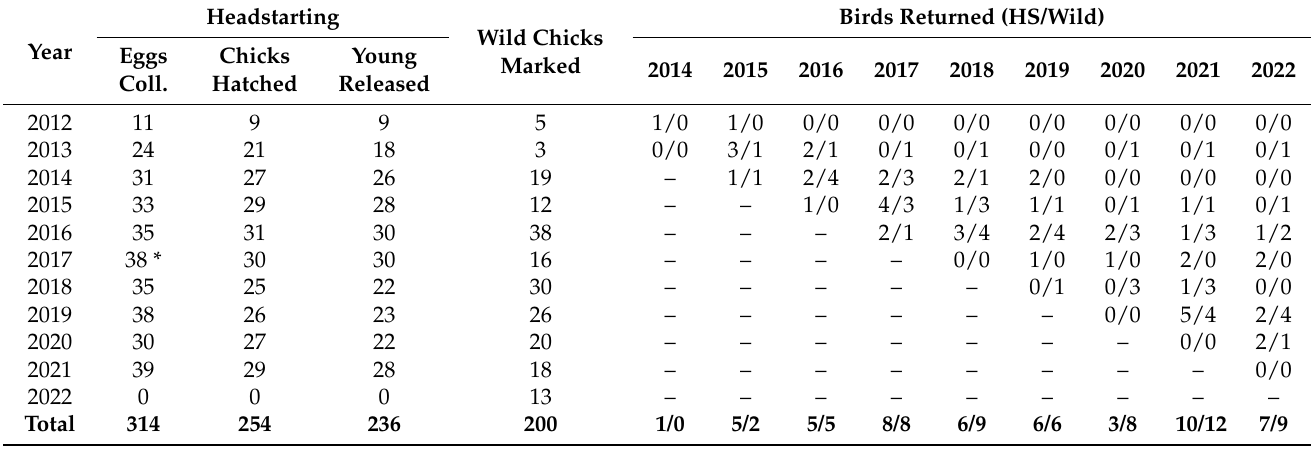
Table 3. Numbers of SbS chicks marked in 2012–2022 which returned to the natal area in subse- quent year(s).